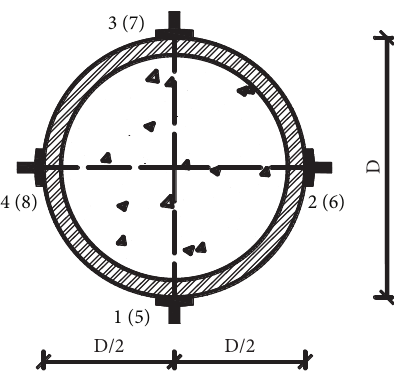
Figure 2: Locations and numbering of strain